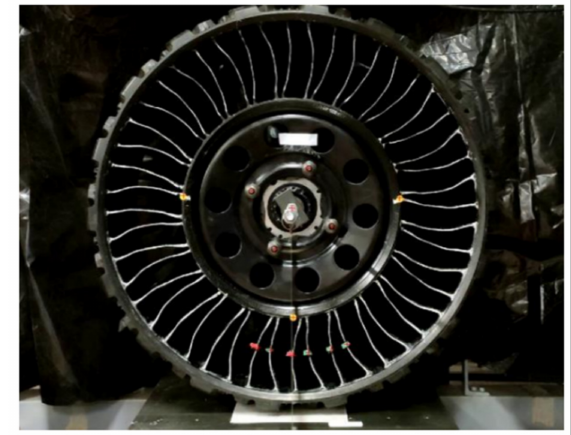
Figure 4. NPT setup for DIC tool.